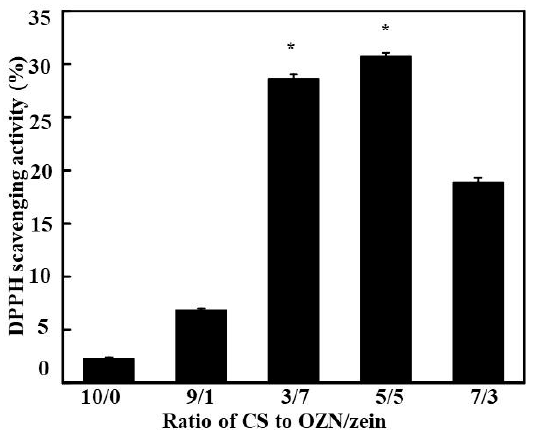
Figure 8. DPPH radical scavenging activity of different composite films on the 12th day (*: p < 0.05).